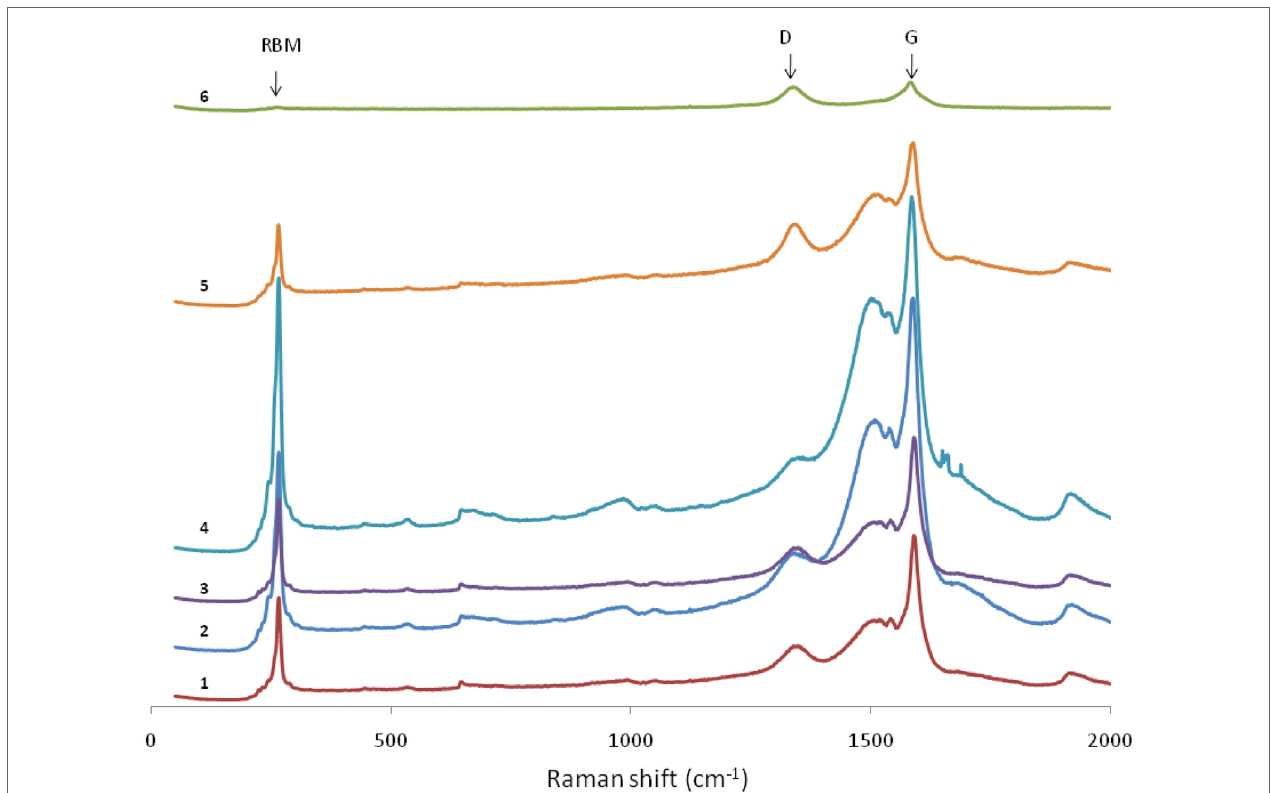
FigUre 4 | laser raman spectra of sWcnTs produced at different cVD temperatures . From 1 to 6, the reaction temperature corresponds to 720, 770, 820, 870, 920, and 970°C, respectively. In this case, the spectra were obtained from a microspectrometer using an Ar + ion excitation laser at λ = 514 nm, with a beam spot ~10 μ m and the laser output ~15